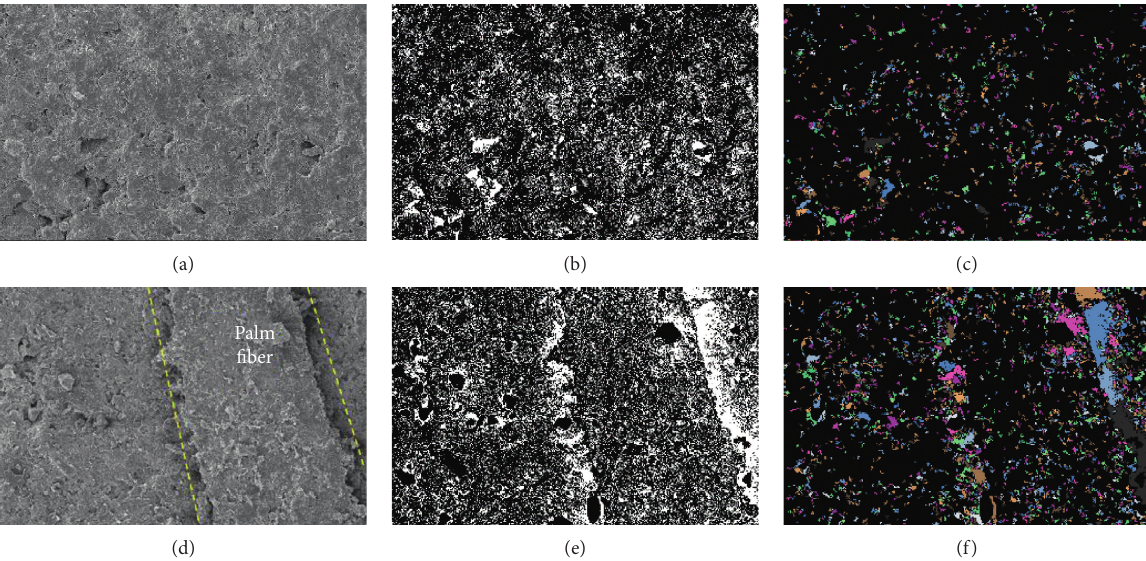
Figure 10: SEM image processing results of unreinforced and reinforced soil under the same shear stress ( τ � 342kPa). SEM images of unreinforced soil: (a) original; (b) with binary image processing; and (c) with vectorization. SEM images of 0.6% reinforced soil: (d) original; (e) with binary image processing; and (f) with vectorization.